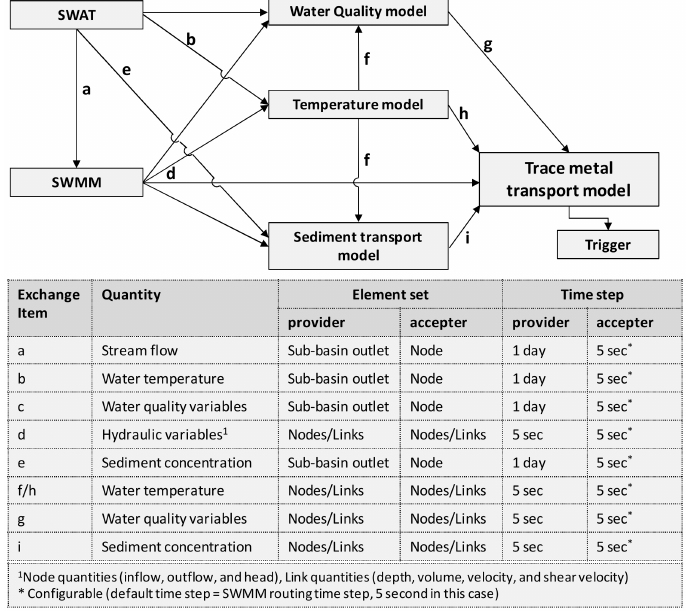
Figure 2. Model components of the integrated trace metal transport model and the data exchange between the components in Open Modelling Interface